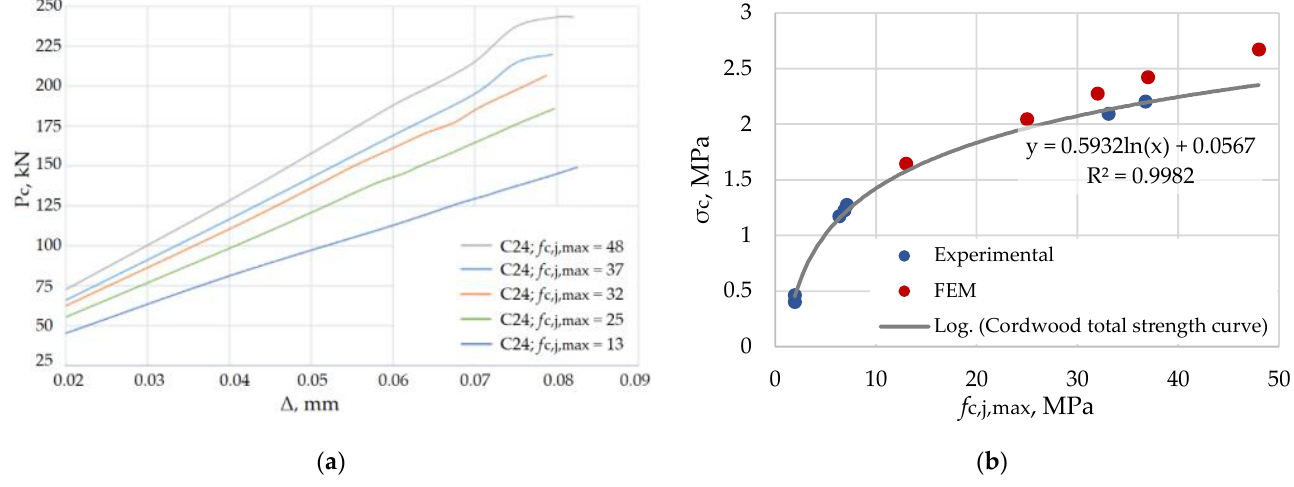
Figure 13. Influence of the wood strength classes on the behaviour of cordwood: ( a ) force/deformation curves for the cordwood specimen differed with the wood strength classes; ( b ) compressive strength of cordwood as a function of the strength classes of the wood.